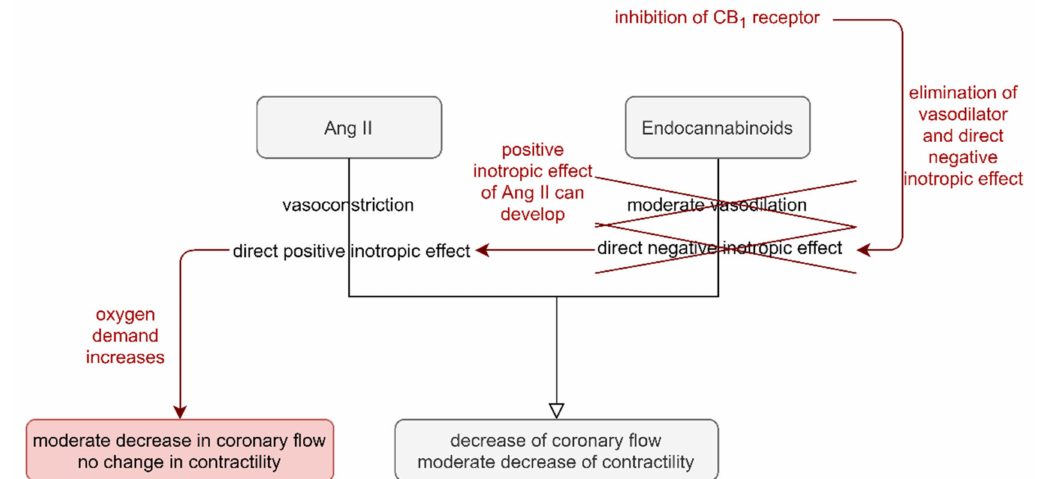
Figure 7. Postulated mechanism of the role of angiotensin II-induced (Ang II) 2-arachidonoylgycerol (2-AG) release in Ang II-induced short-term cardiac effects. Ang II causes vasoconstriction of the coronaries and has positive inotropic effects on cardiomyocytes. On the other hand, 2-AG release during Ang II signalling causes moderate vasodilation and has negative inotropic effects. The summation of these opposing effects manifests in diminished coronary flow (CF) accompanied by a moderate decrease in contractility in the Langendorff-perfused rat heart (black arrows). Inhibition of CB 1 receptor, and 2-AG generation eliminates the counteraction of 2-AG on the positive inotropic effect of Ang II. The unopposed positive inotropic effect of Ang II enhances cardiac oxygen demand, which counterregulates the vasoconstrictor effect of Ang II. As a result, the flow-reducing effect of Ang II is moderated, and the opposing effects of diminished CF and increased contractility cancel each other out, leaving the contractile function unaltered (red arrows).